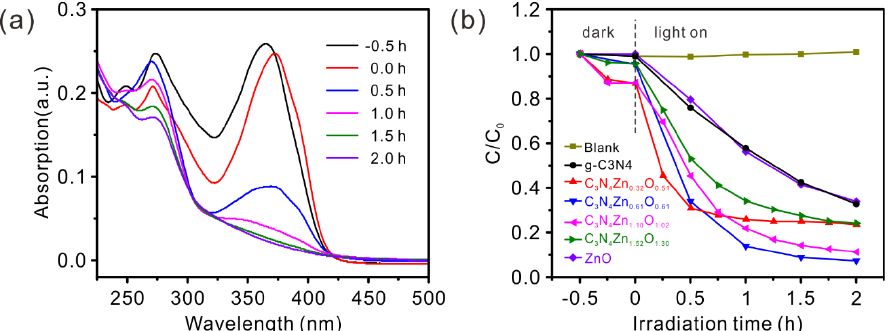
Figure 6. ( a ) The absorption spectra of TC-HCl solution (10 mg/L) at different irradiation times under visible light, using C 3 N 4 Zn 0.61 O 0.61 as the photocatalyst. ( b ) Photocatalytic degradation efficiencies of TC-HCl using g-C 3 N 4 , C 3 N 4 Zn x O y , and ZnO as the photocatalysts under visible light irradiation (420– 780 nm, 0.6 W/cm 2 ).